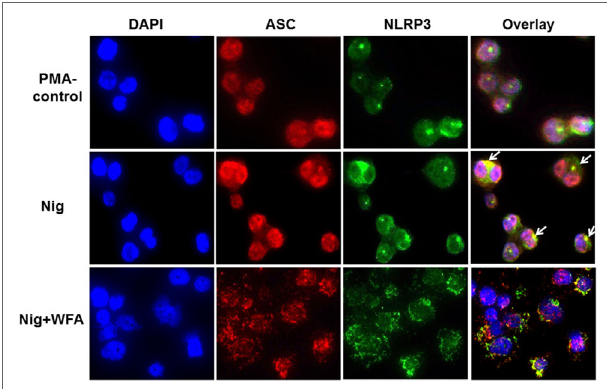
FigUre 5 | Representation of confocal fluorescence images (magnification 40 × ) of THP-1 cells analyzing the effect of dietary agent withaferin A (WFA) following NLRP3 inflammasome activation using nigercin. ASC and NLRP3 proteins were visualized by using Cyanine Cy TM 3 (red-fluorescent) and Alexa Fluor 488 (green-fluorescent) dye labeled antibodies, respectively. DAPI was used for nuclear staining. A merged image of ASC and NLRP3 proteins shows co-localization of inflammasome complex proteins (yellow, marked by arrow). The experiment was performed four times from independent cell preparations.